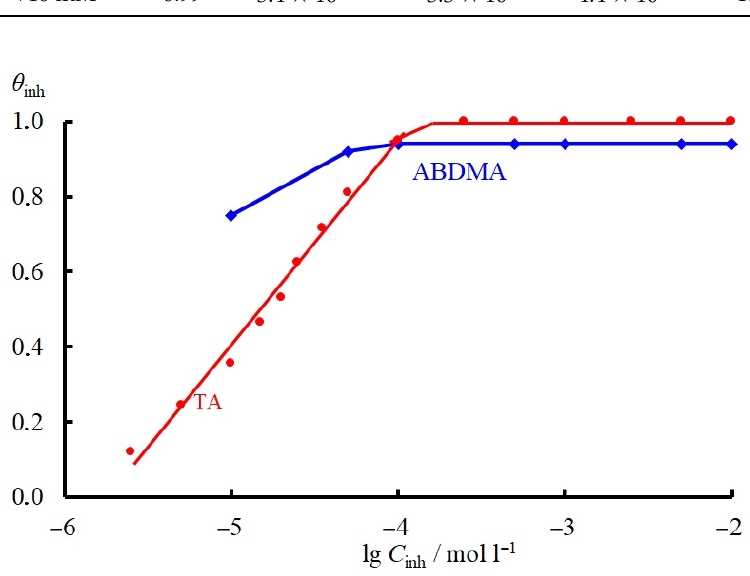
Figure 6. Equivalent electrical circuit and Nyquist plots of a steel electrode (0.64 cm 2 ) in 2.0 M HCl recorded after adding 0.01 mmol TA to the solution with various exposure times.